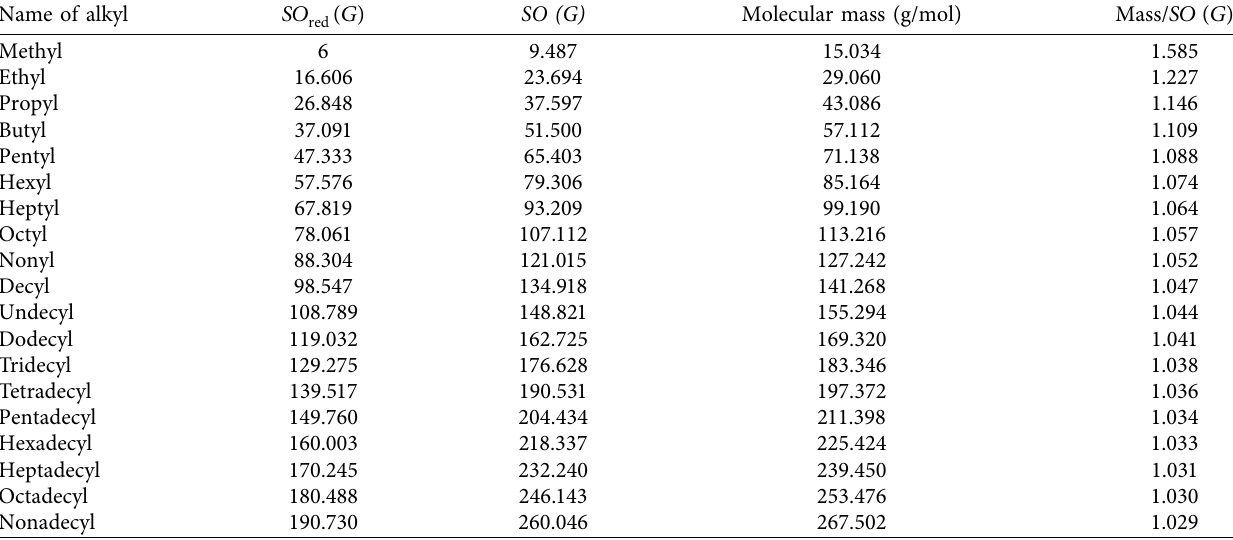
Table 3: Sombor index and molecular mass values of some alkyls.